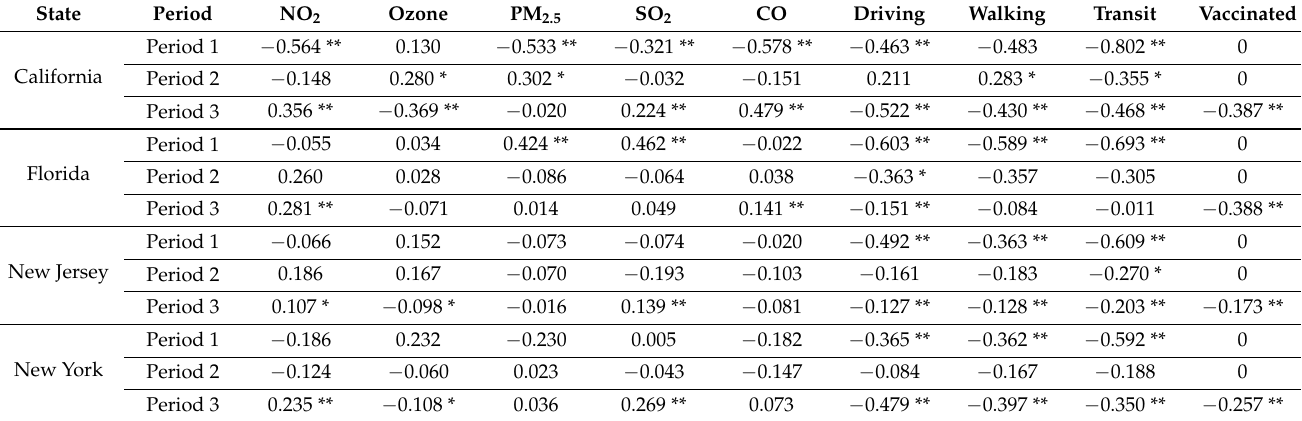
Table 3. Correlation analysis results of air pollutants, population movement, and vaccination